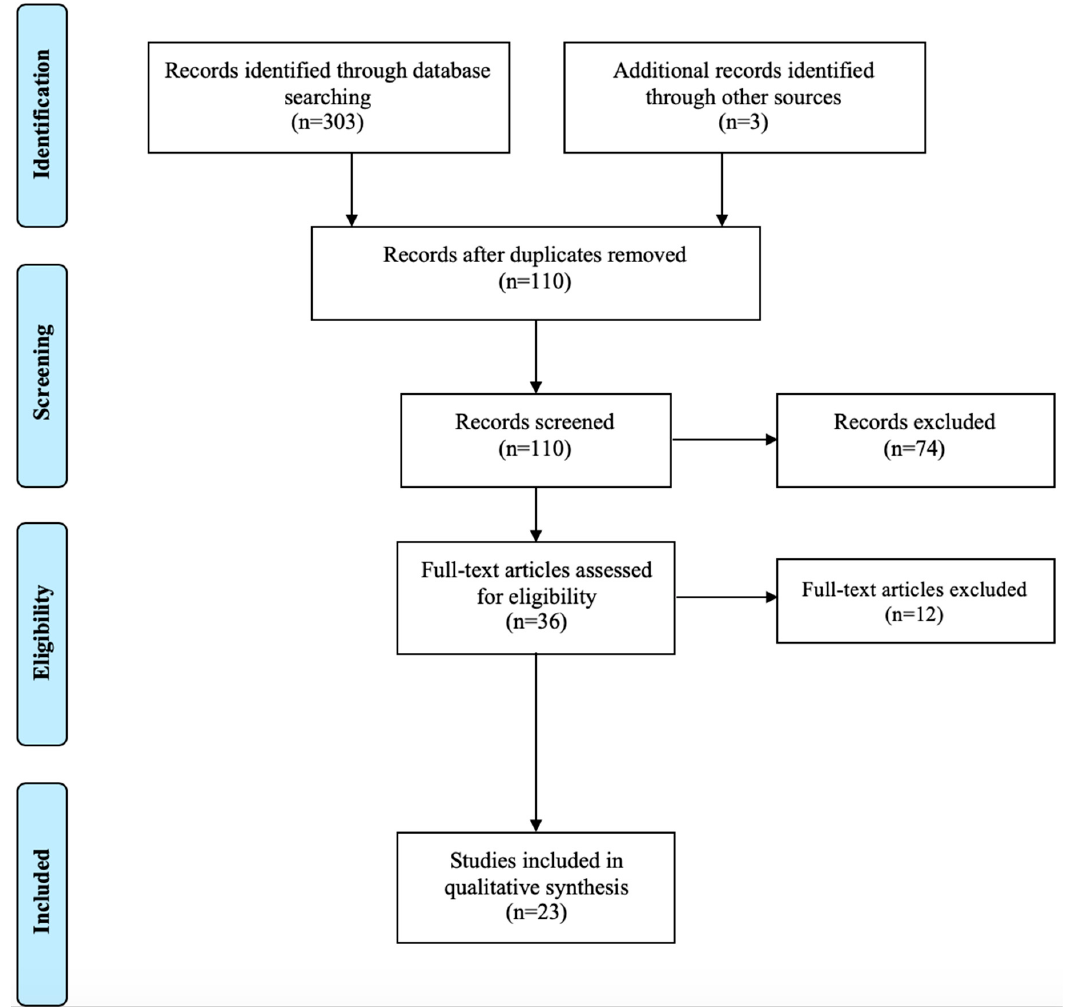
Figure A1. Flow diagram of the database search, screening and inclusion of the studies (modified after the PRISMA guidelines [45].